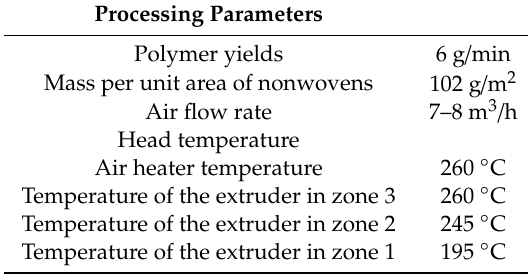
Table 2. Melt-blown technique processing parameters applied for preparation of PLA